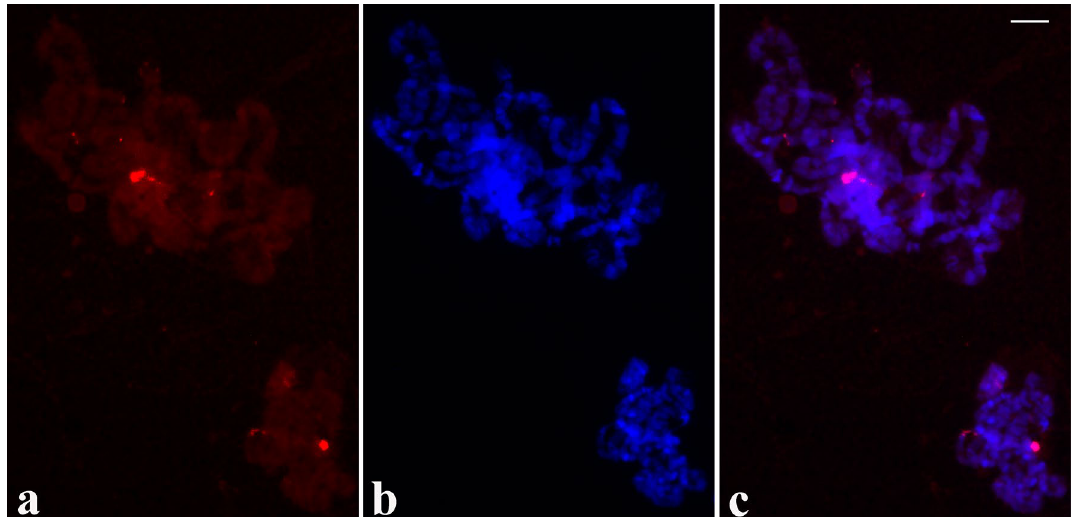
Figure 5. ( a–c ) Localisation of the rDNA in Schwenkfeldina sp. polytene chromosomes from Malpighian Tubules showing RNA probe signal ( a ), its corresponding DAPI staining image ( b ) and the merged signals